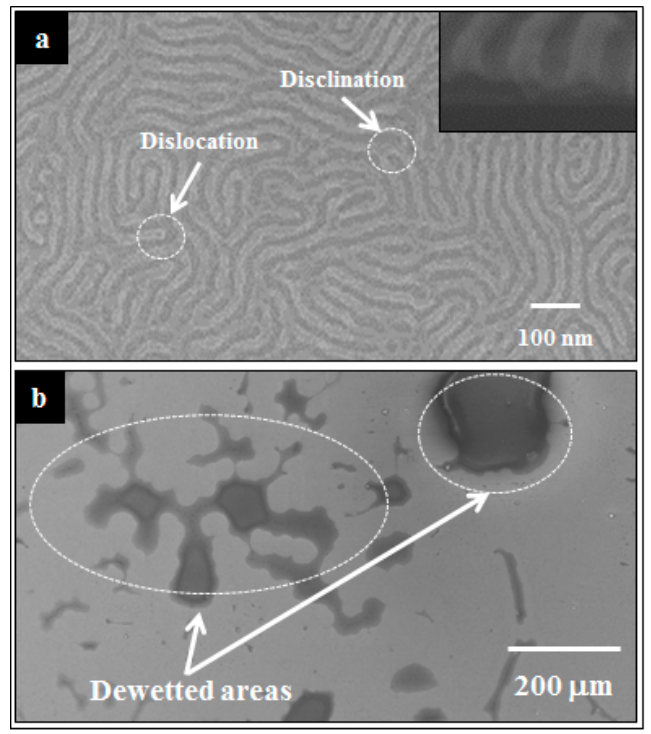
Figure 1. ( a ) Top-down SEM image (inset, cross-section image). Various defects noted in the micrograph and ( b ) top-down SEM images showing the coverage of microphase separated PS- b -PDMS film (as revealed by ETCH1 (CF 4 and O 2 etches)).